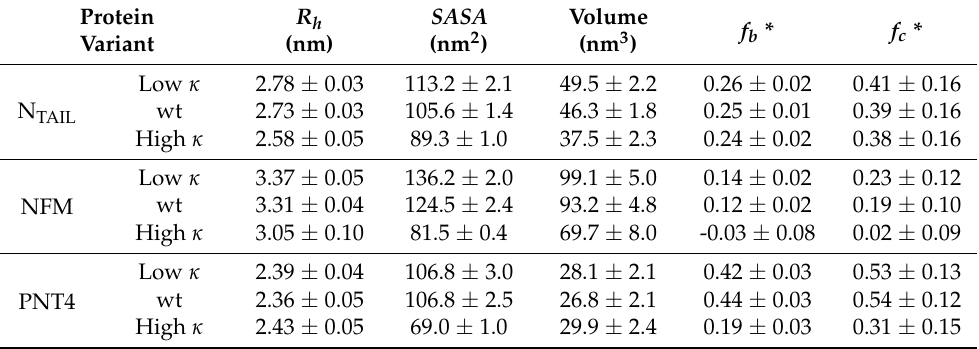
Table 2. Hydrodynamic radii ( R h ) and average solvent accessible surface area ( SASA ) of the three model proteins and their derived κ variants. Mean values and standard deviations from three independent measurements are reported. Volume, surface area and flattening indices of the ellipsoids were derived from the model proposed by Wu and co-authors